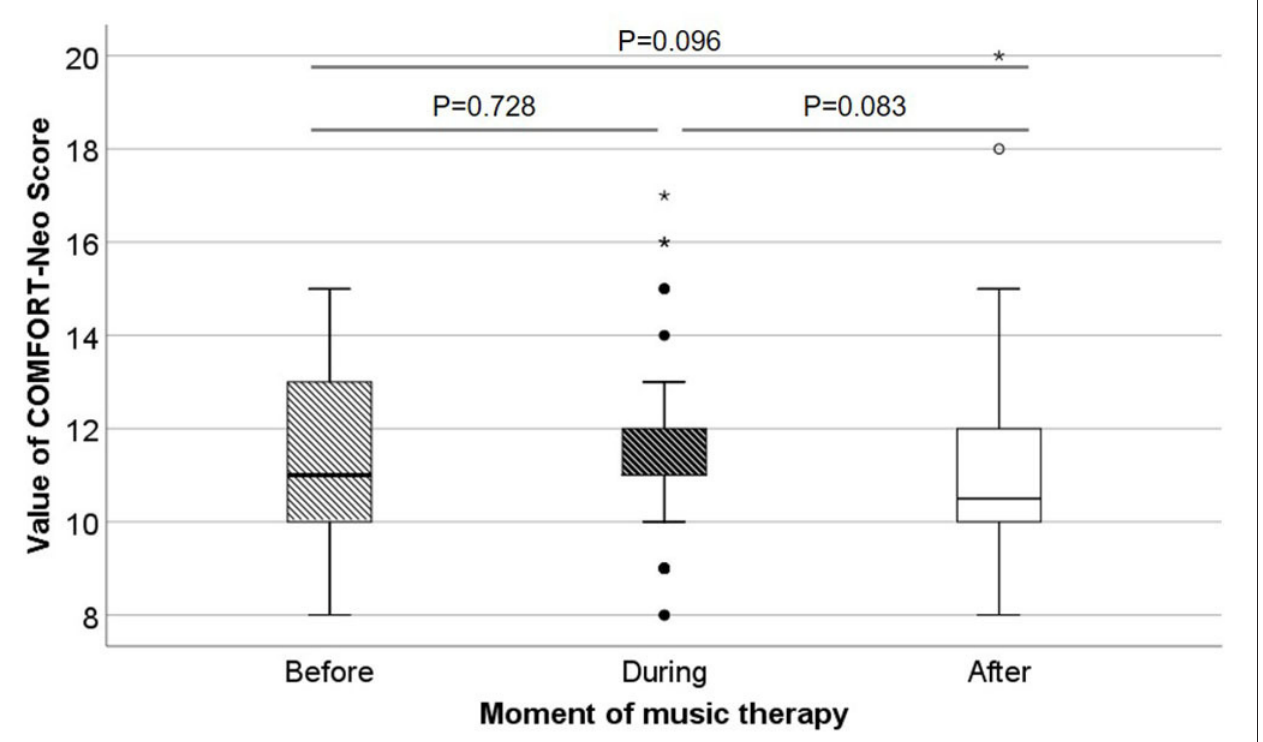
FIGURE 1 | COMFORT-Neo scores before, during and after music therapy. In this box whisker plots, the boxes represent the interquartile ranges, the whiskers represent the range of all ages and the dots and stars represent outliers.